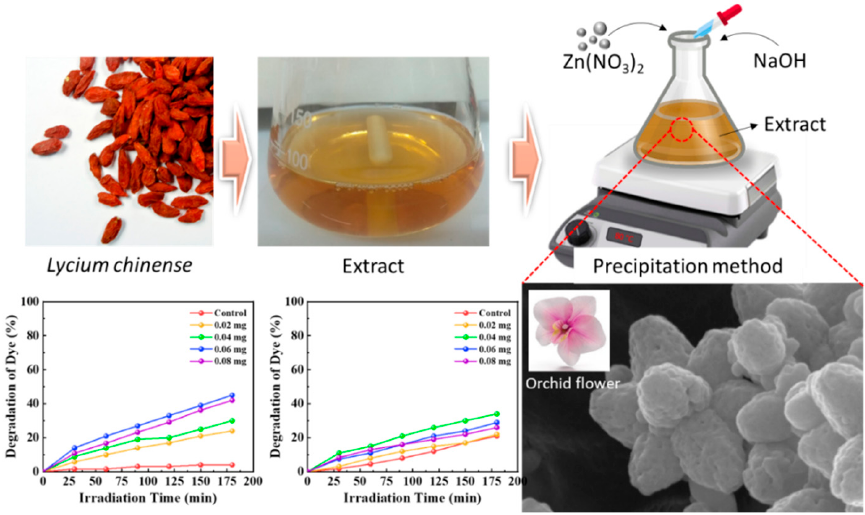
Scheme 1. Biosynthesis process of LC-ZnO/OF using Lycium chinense extract.